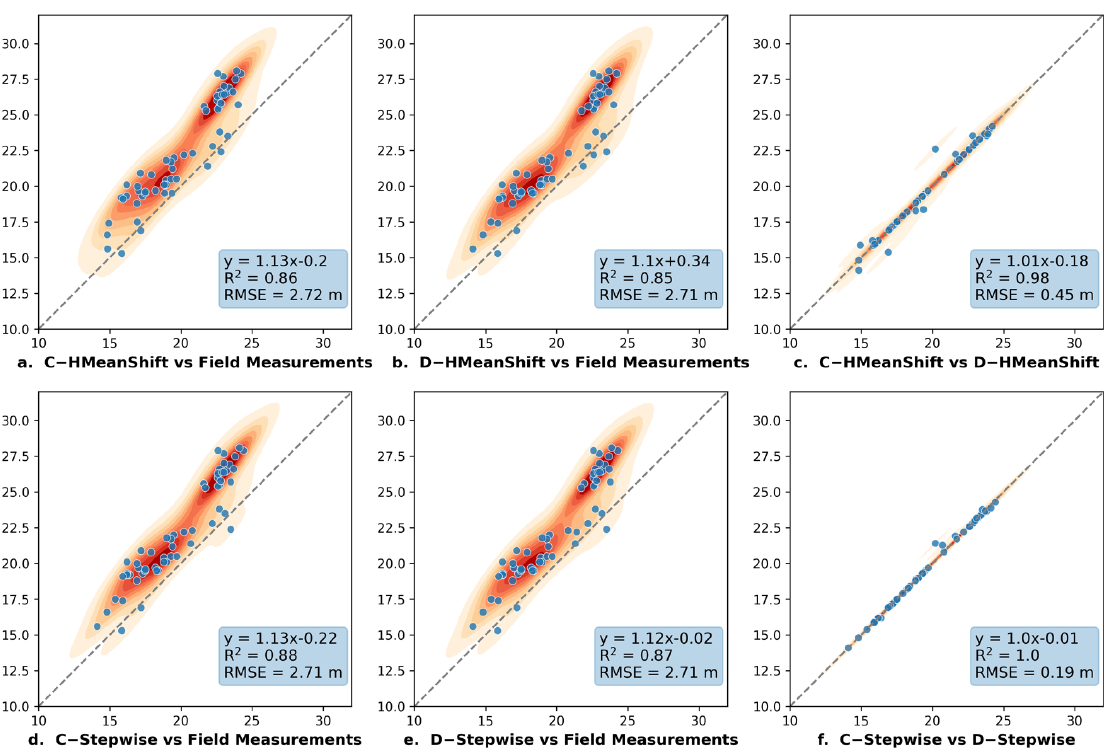
Figure 5. Correlations with heatmap in estimations of tree height between the field measurements and the designed approaches. Dash lines are x = y; the blue box includes regression line expression, R-squared, and RMSE.